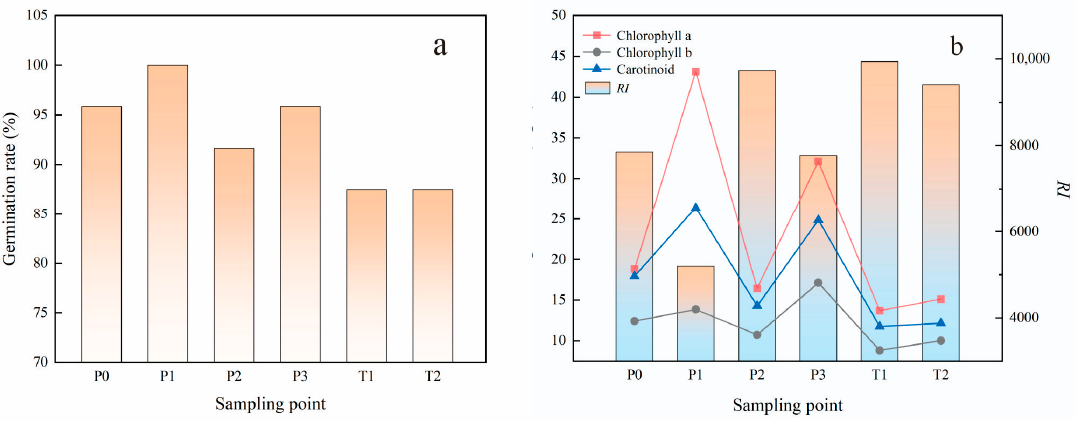
Figure 4. Relationship between germination rate ( a ), potential ecological risk RI value and pigment content of Vicia faba L. ( b ).